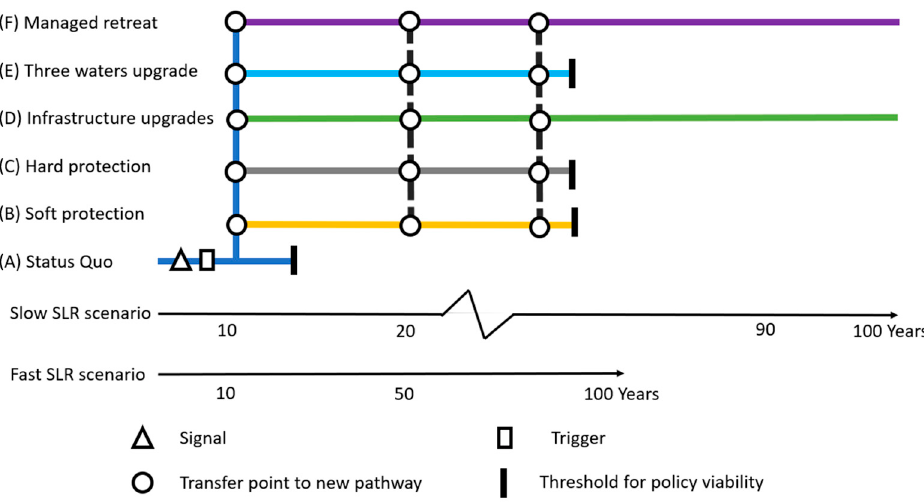
Figure 1. Example DAPP ‘metro map’ showing a range of actions available (left axis) and potential transfer points (circles) between actions (coloured lines). Some actions (e.g., actions A, B and D) will reach adaptation thresholds faster than others (e.g., actions C and E) and therefore have shorter life spans. We tested the lifetimes of different actions by integrating a DAPP into the model. Each coloured line represents a different adaptive action.